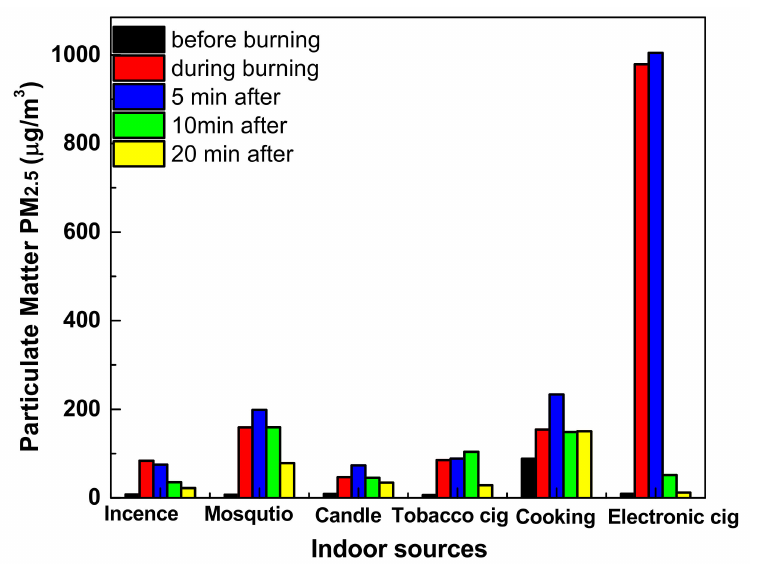
Figure 5. Particulate matter mass concentration (PM 2.5 ) for six indoor aerosol sources (incense, mosquito coils, candles, tobacco cigarettes, cooking and electronic cigarettes) at different times (before being turned on, during operation and after being stopped).